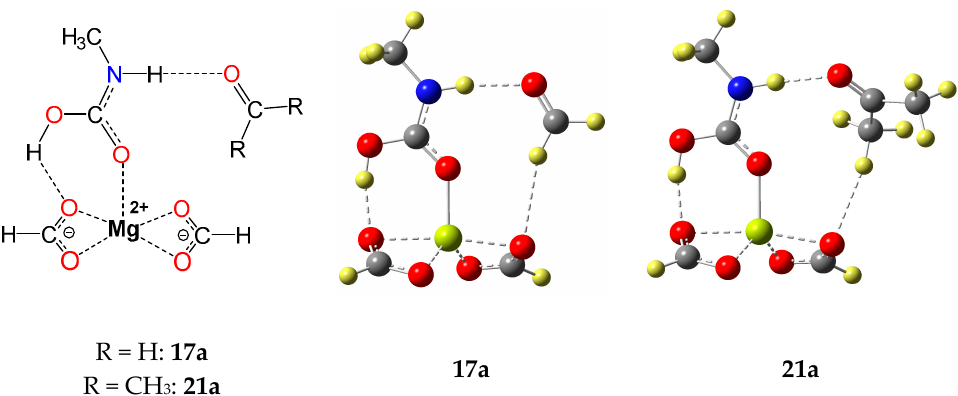
Figure 2. Molecular model of aggregates 17a and 21a formed between the magnesium formate MgL 2 complexed trans-trans isomer of N -methylcarbamic acid and model carbonyl formaldehyde (FA) or acetone (Ac), respectively. (Ball and Bond Type models are shown and color indicates elements: oxygen: red; nitrogen: blue; carbon: grey; hydrogen: yellow; magnesium: lime). Table 1. Thermochemical data for capture systems. 1